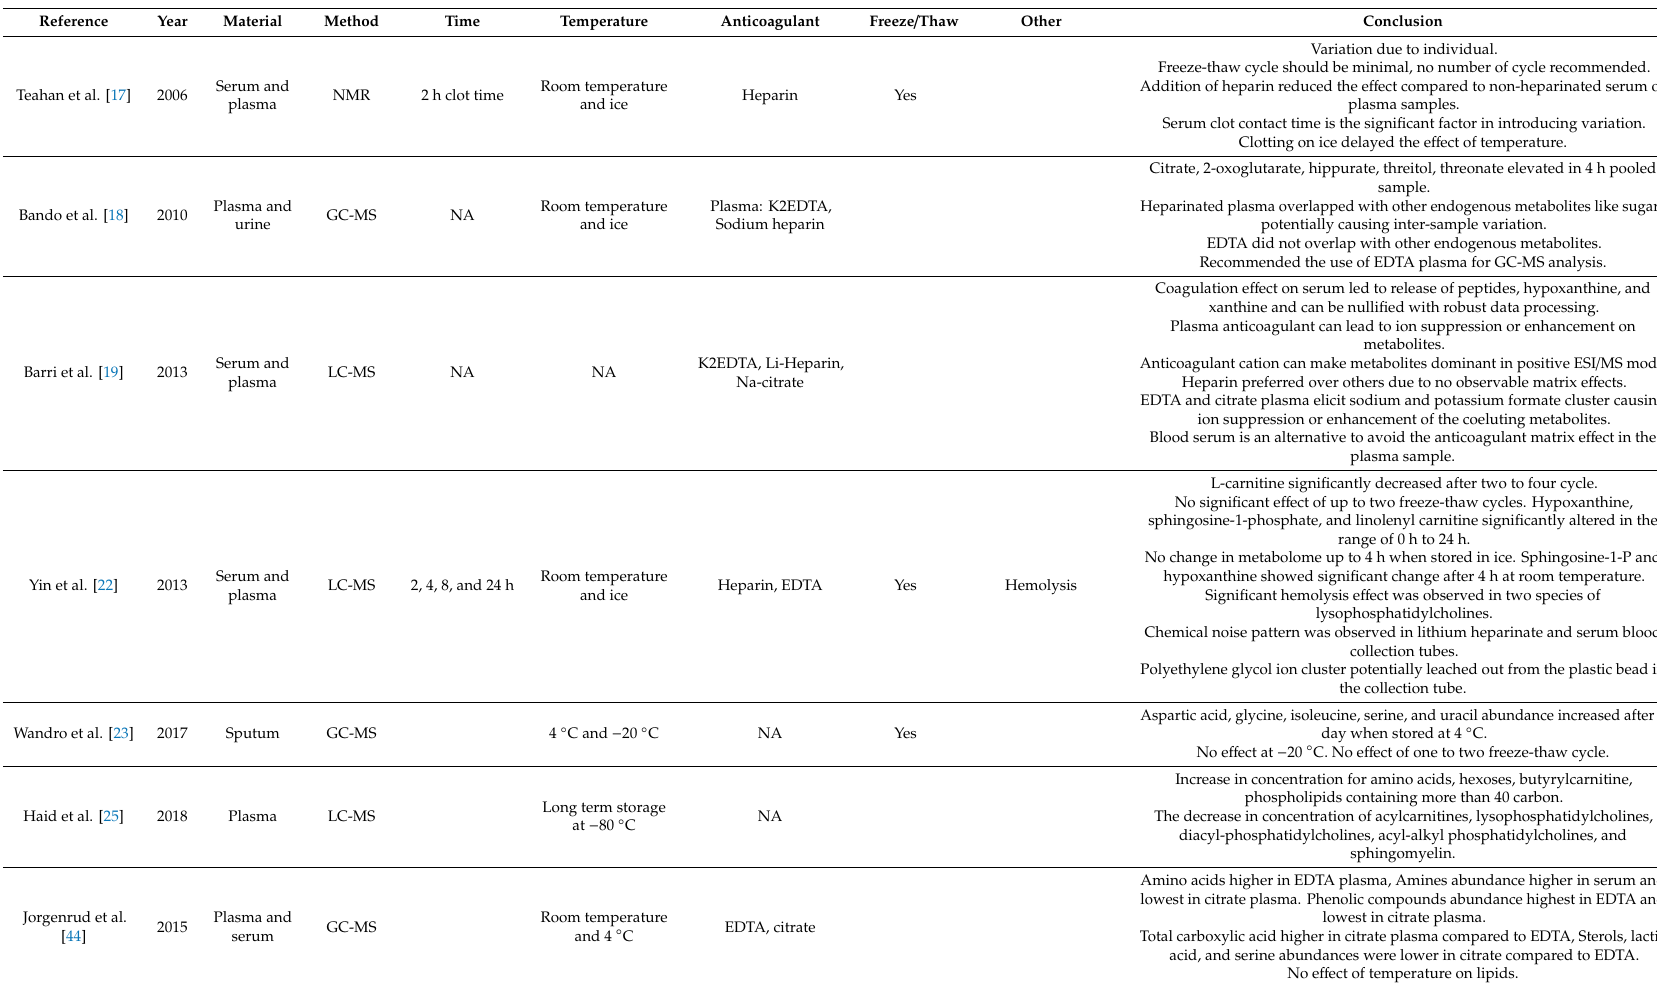
Table 1. E ff ect of di ff erent physical and chemical parameters on lipids and metabolites in various biological